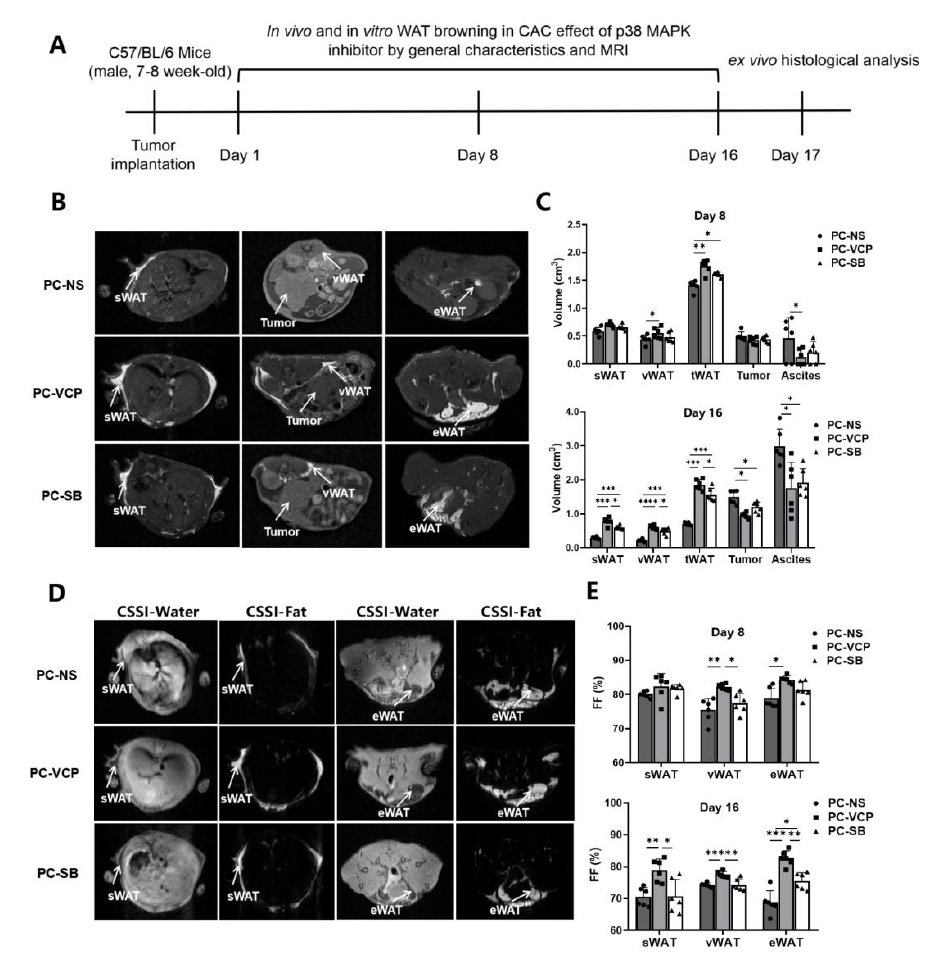
Figure 4. Monitoring the therapeutic effect of p38 MAPK inhibitors in mice with pancreatic cancer. ( A ) Scheme of experiments for tracking and the evaluation of treatment. ( B ) Examples of T 1 WI of selected mice in different groups. ( C ) MRI-measured volumes of sWAT, vWAT, tWAT, tumors and ascites on the 8th and 16th day after modeling. ( D ) Examples of CSSI of selected animals in different groups. ( E ) CSSI measured FF% of sWAT, vWAT and eWAT on the 8th and 16th day after starting the treatment. (* p < 0.05, ** p < 0.01, *** p < 0.001, **** p < 0.0001). CAC = cancer-associated cachexia, CSSI = chemical shift-selective imaging, eWAT = epididymis white adipose tissue, FF = fat fraction, MRI = magnetic resonance imaging, p38 MAPK = protein-38 mitogen-activated protein kinase, PC = pancreatic cancer, sWAT = subcutaneous white adipose tissue, T 1 WI = T1 weighted image, tWAT = total white adipose tissue, vWAT = visceral white adipose tissue, WAT = white adipose tissue.